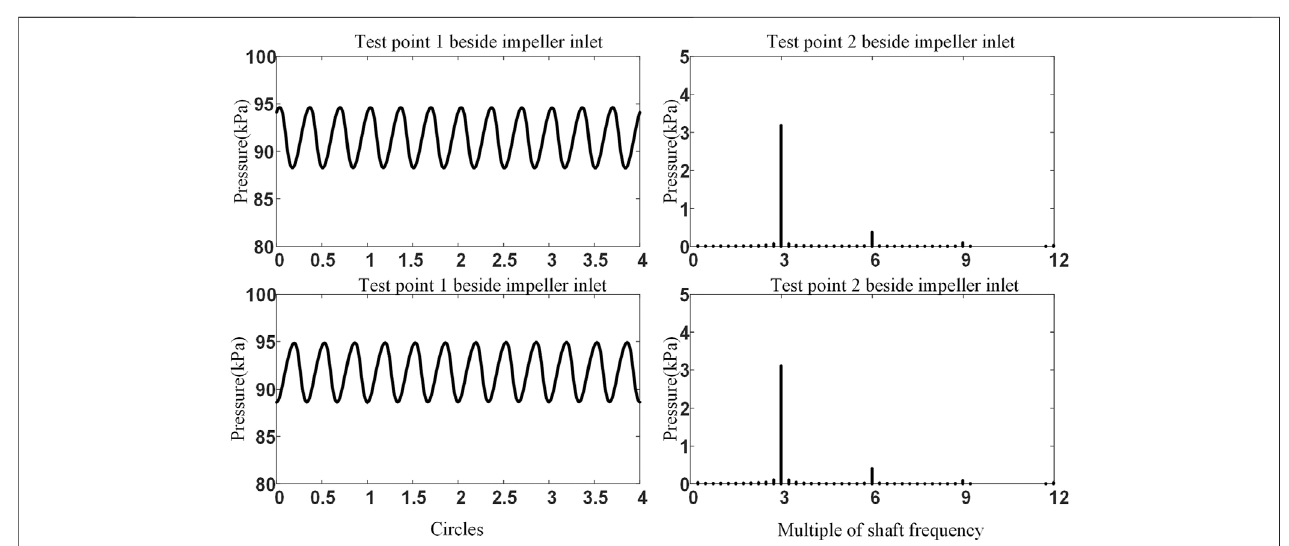
FIGURE 13 | Time frequency domain diagram of pressure by